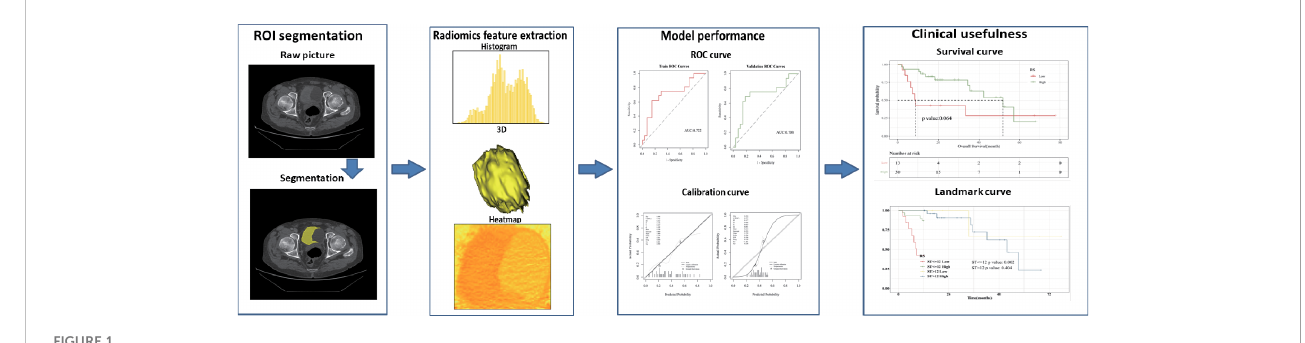
FIGURE 1 The work fl ow of radiomic in this